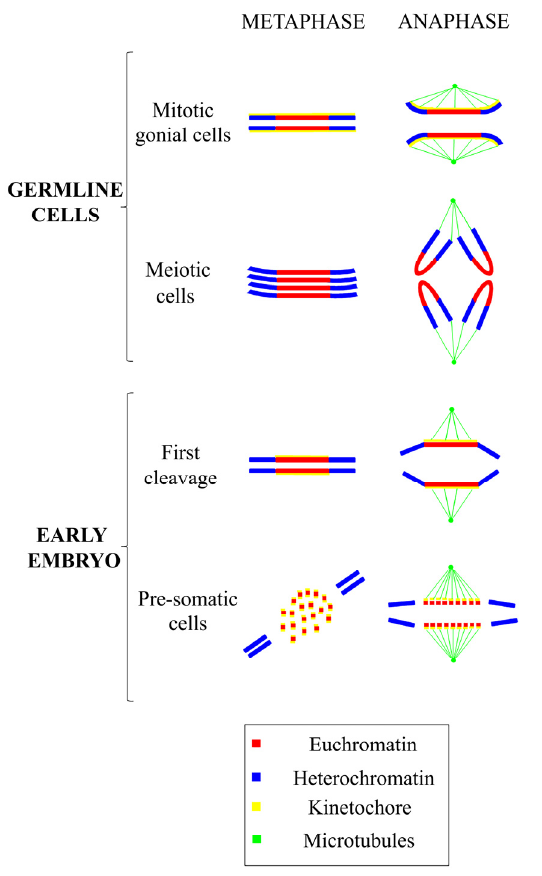
Figure 3. Diagrammatic representation of the variations in the centromere position and chromatin and kinetic activity in different cell types. Note, kinetic activity is retained exclusively by euchromatin in embryonic presomatic cells, in gonial cells by the entire chromosome and in meiotic cells only by telomeric heterochromatin.